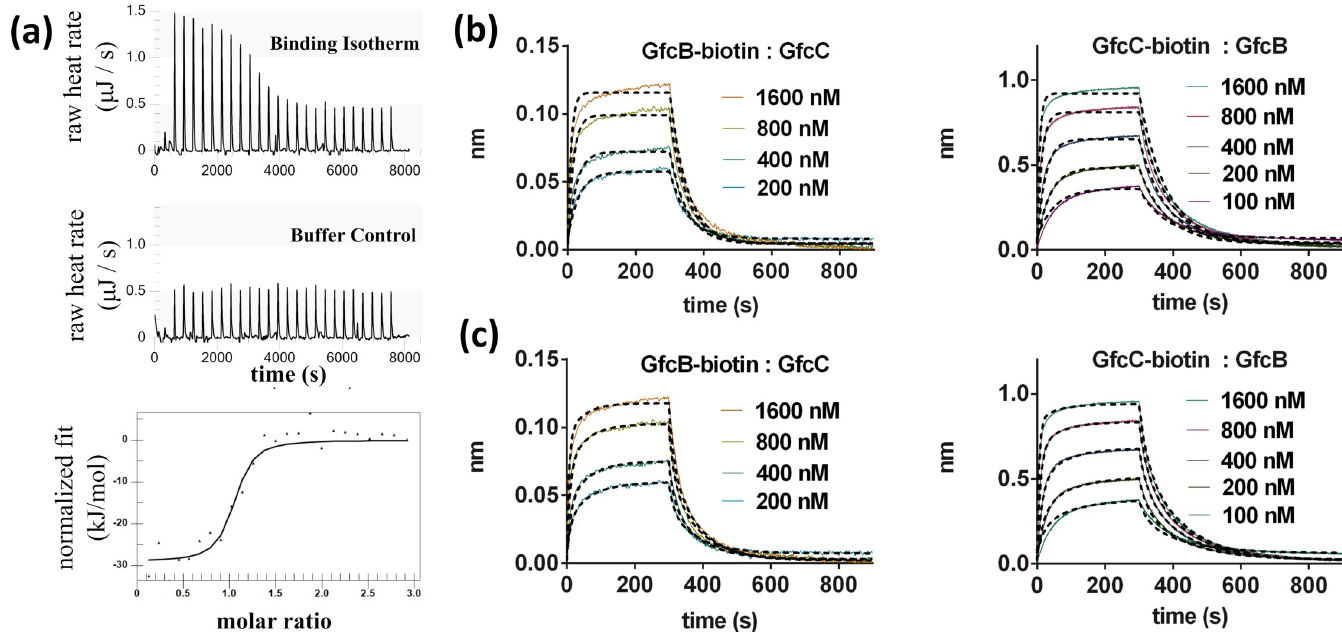
Fig 4. GfcB and GfcC form a tight complex. (a) Isothermal calorimetry. 24 injections of GfcB into GfcC at 25˚C were measured ( upper ) and the heat released ( μ J) at each injection was subtracted by the heats released for the control injections in buffer (middle) and were fit ( lower ). GfcB-GfcC have a 1:1 interaction with K D of 0.1 μ M in solution. ( b ) Biotinylated GfcB was anchored to an SA (streptavidin) sensor and the real-time binding response of GfcC at concentrations of 200 nM to 1.6 μ M were measured by BLI. ( c ) Biotinylated GfcC on the sensor and binding of GfcB (with C-terminal His 6 -tag expressed from pET-BLUE2) at concentrations of 100 nM to 1.6 μ M were measured. The BLI data in ( b ) and ( c ) were fit with either a one-site binding model ( top ) or one-site binding followed by conformation change model ( bottom ).